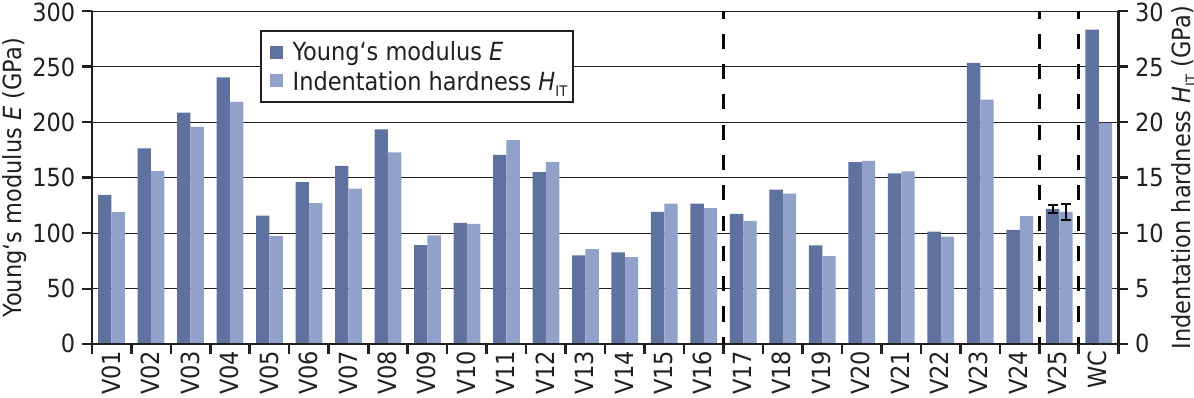
Figure 4. Young’s modulus E and indentation hardness H the WC coating. Both mechanical properties vary strongly depending on the respective set of deposition